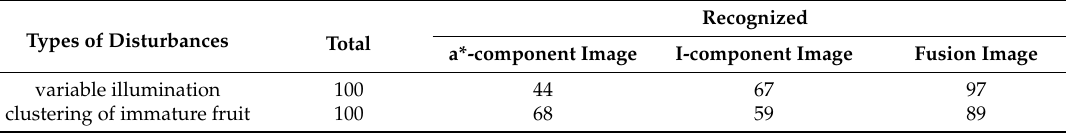
Table 1. Performance analysis of different recognition algorithms.